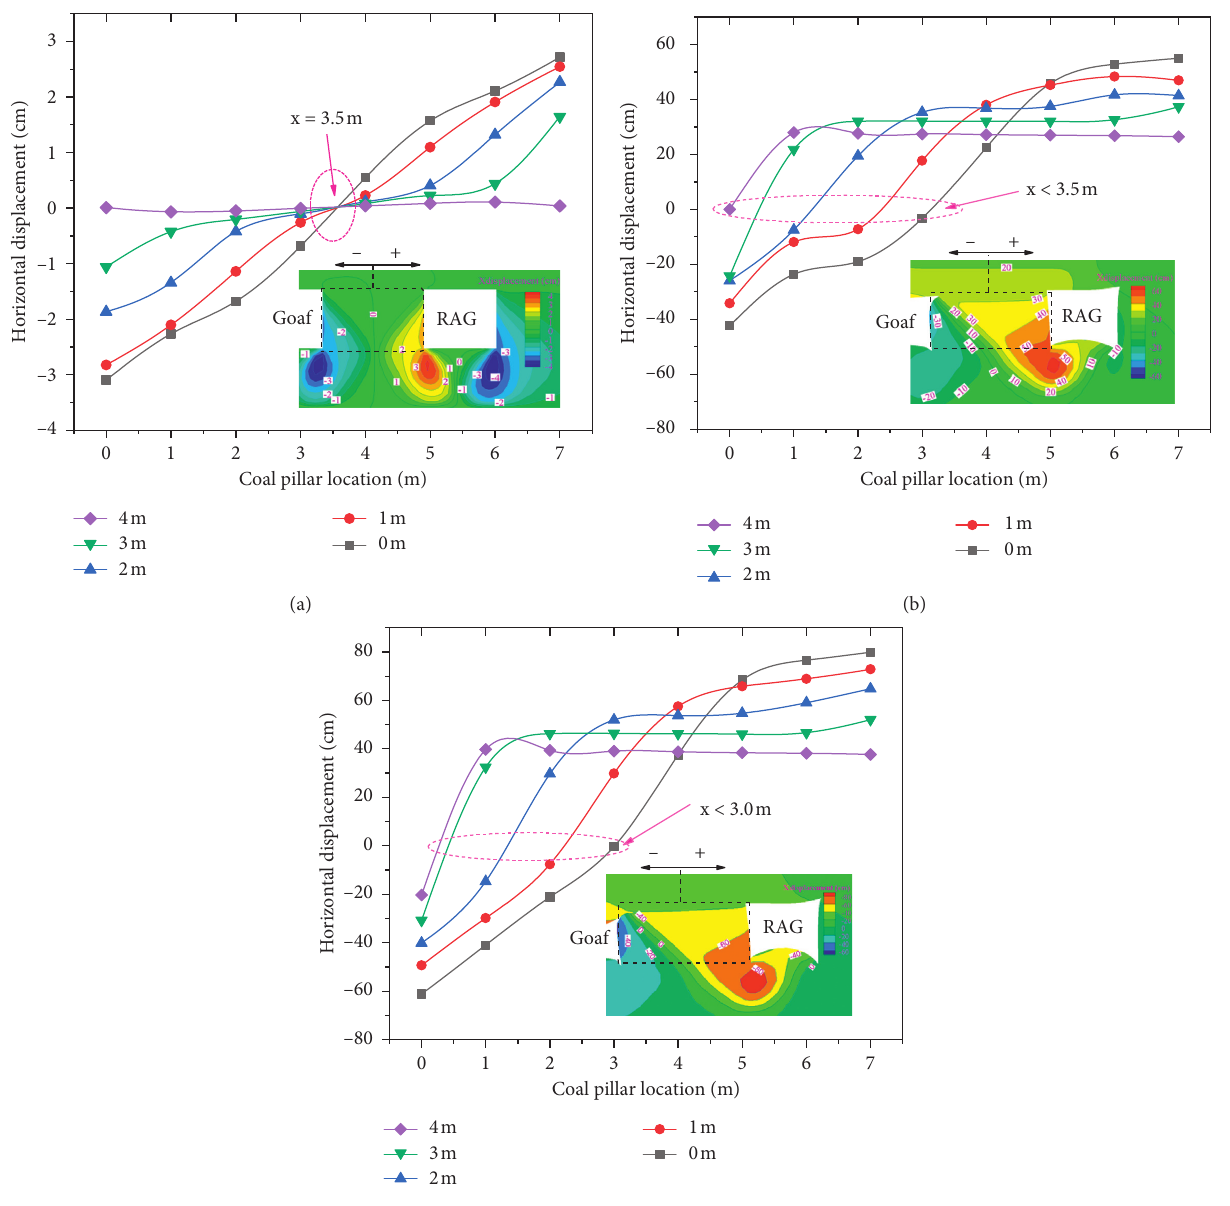
Figure 12: Simulated distributions of horizontal displacement within the pillar in the three stages. (a) Stage A. (b) Stage B. (c) Stage